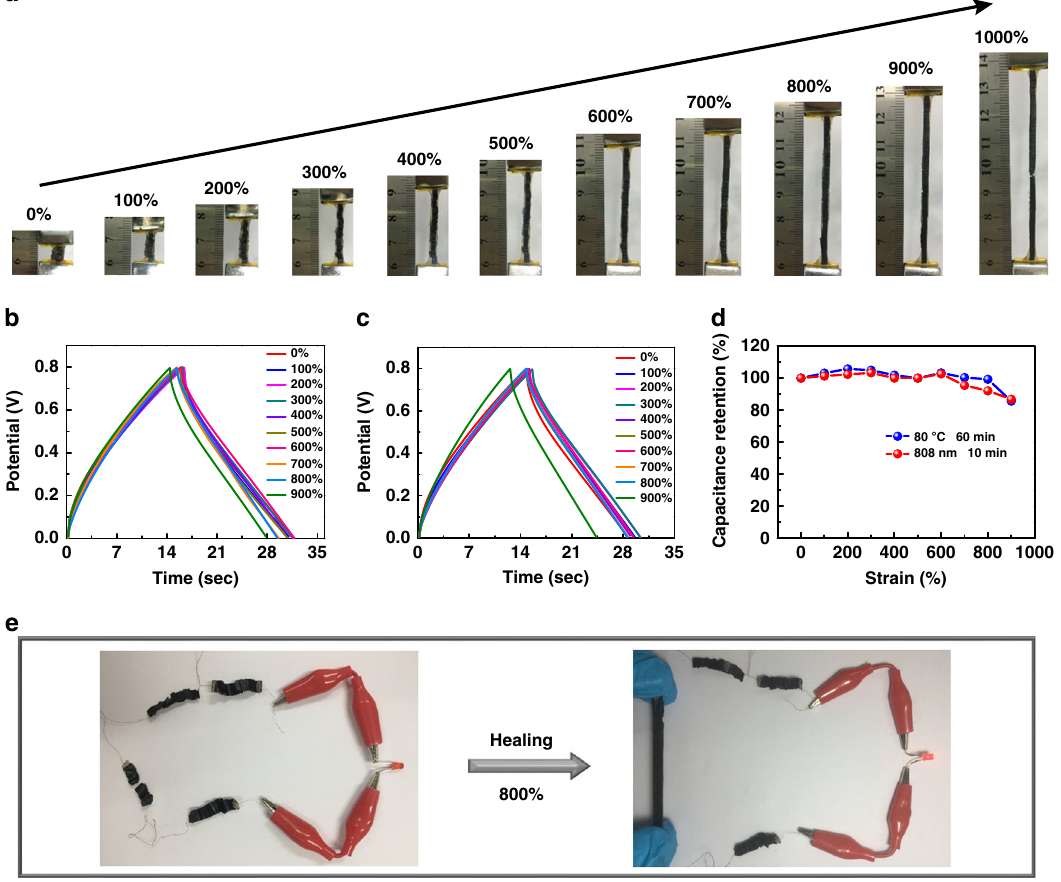
Fig. 4 Stretchable properties of a broken/healed supercapacitor. a Digital photographs of a broken/healed supercapacitor being stretched from 0 to 1000%. b , c Galvanostatic charge/discharge (GCD) curves of a broken supercapacitor healed by infrared light for 10 min ( b ) and heating treatment at 80 °C for 60 min ( c ) as they were stretched from 0 to 900%. d Speci fi c capacitance retention of the broken and healed supercapacitors calculated from the results of b and c . e Digital photographs of four supercapacitors connected in series to power a light-emitting diode (LED), in which one device was broken/healed and then stretched to a strain of